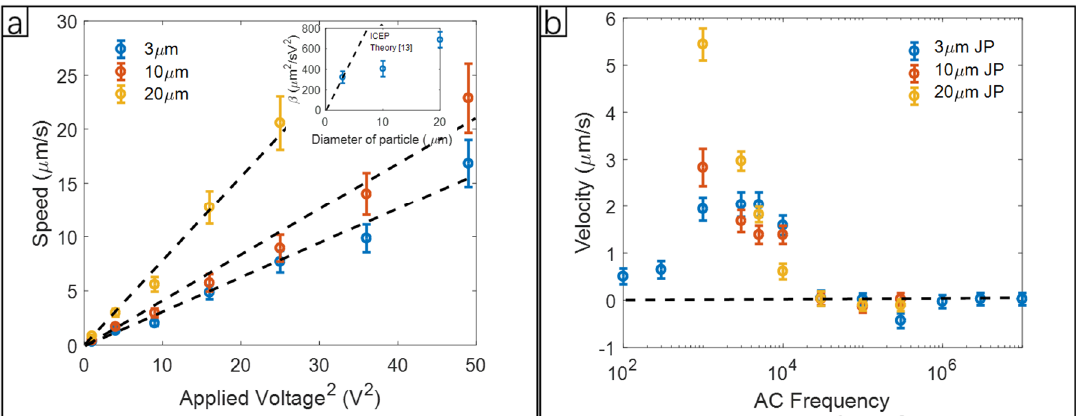
Figure 5. ICEP of a Janus particle without confinement. ( a ) ICEP speed of 3 µ m, 10 µ m, and 20 µ m Janus particles under di ff erent applied voltage at 5 kHz. Insert: β vs. the diameter of the particle. The dashed line is the prediction using Equation (20). ( b ) The velocity of 3 µ m, 10 µ m, and 20 µ m diameter particles under the potential di ff erence 2 V over a 50 µ m gap between the electrodes and with di ff erent frequencies from 100 Hz to 1 MHz. The positive velocity (normal direction) is defined as moving toward the dielectric